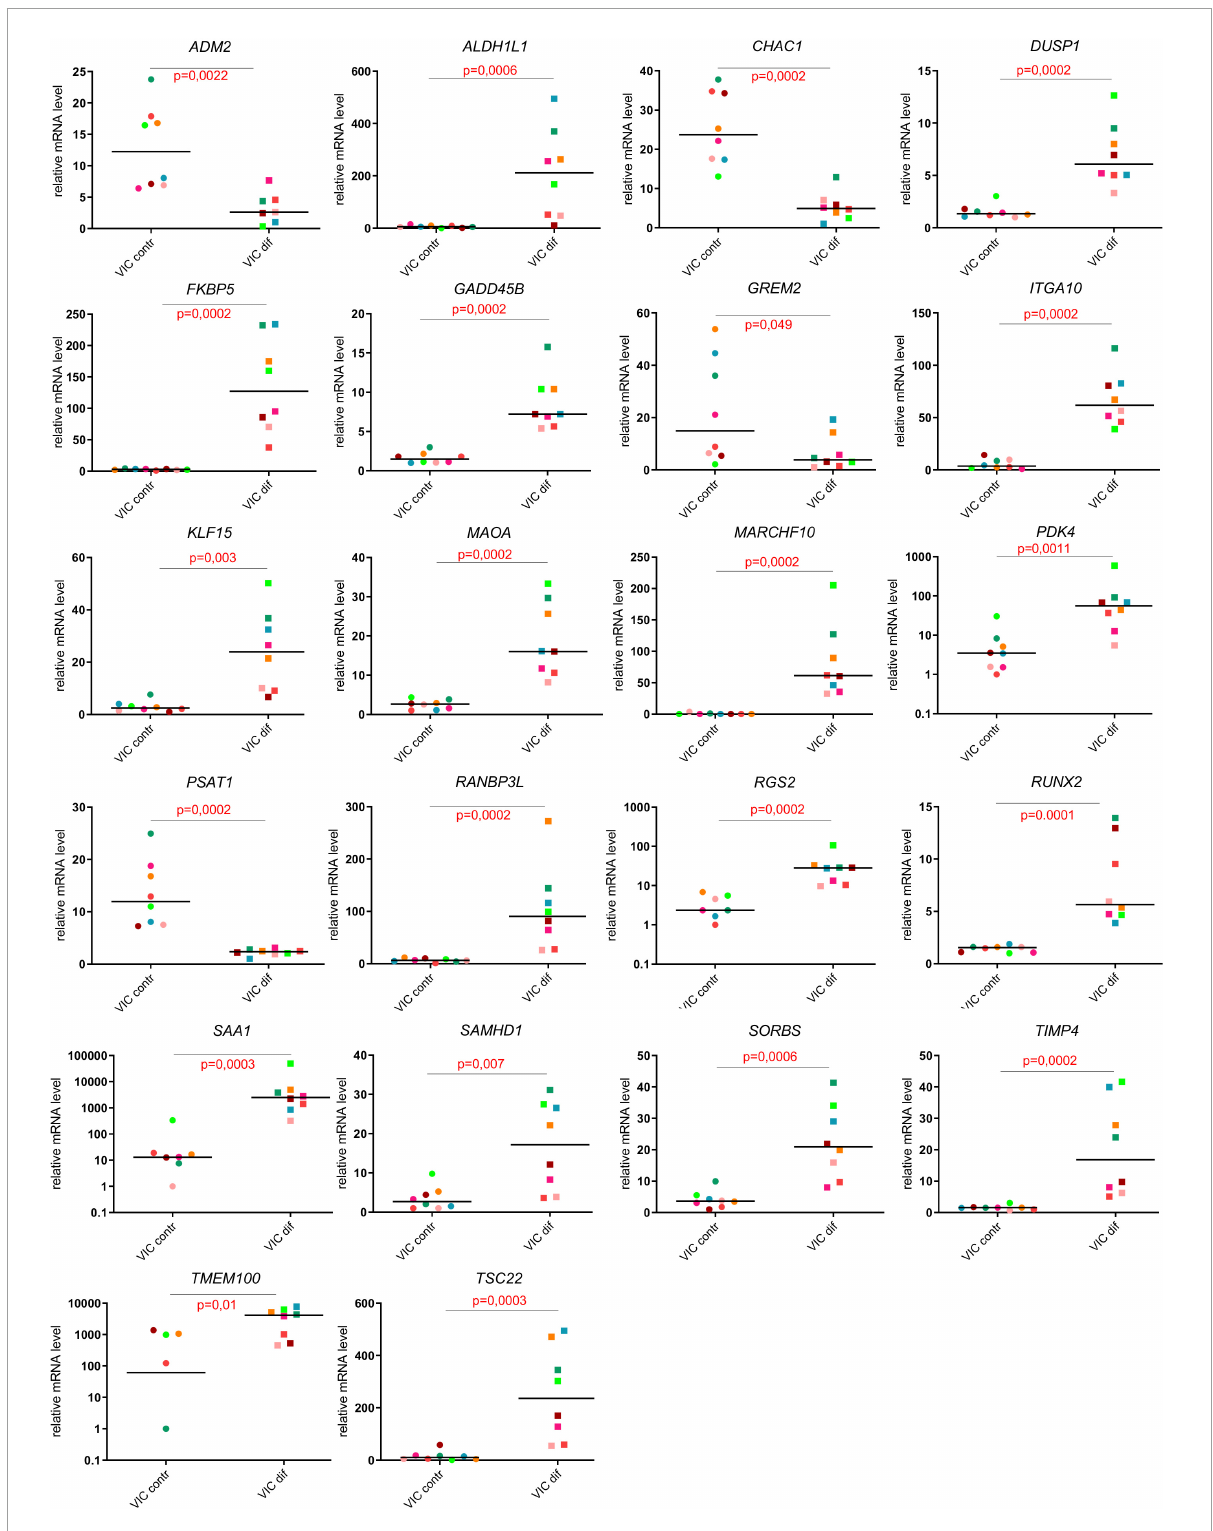
FIGURE5 Evaluation of the expression levels of the most responsive genes in comparison of undifferentiated and differentiated human valve interstitial cells (VIC) from healthy donors and patients with CAVD using